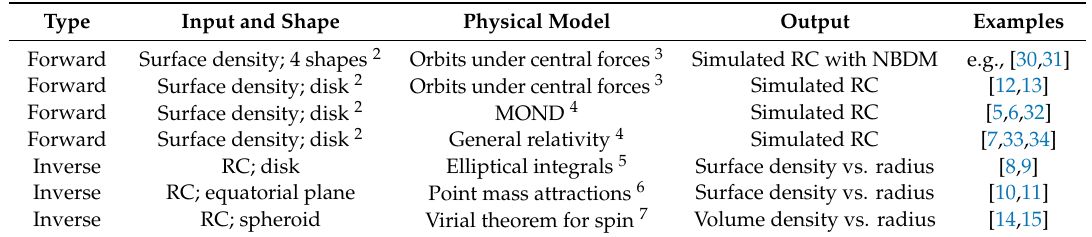
Table 1. Comparison of forward and inverse approaches to RC analysis. 1